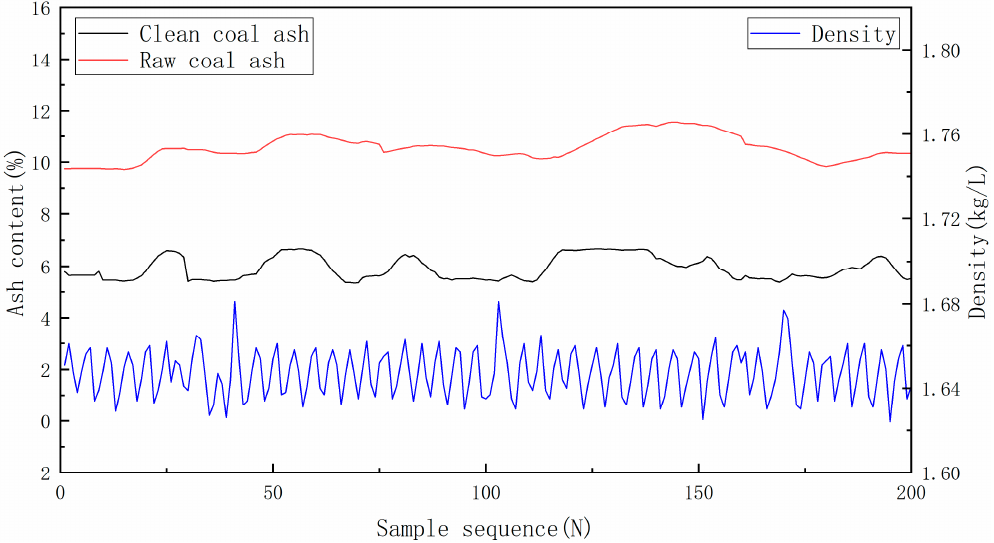
Figure 4. Preprocessed data.